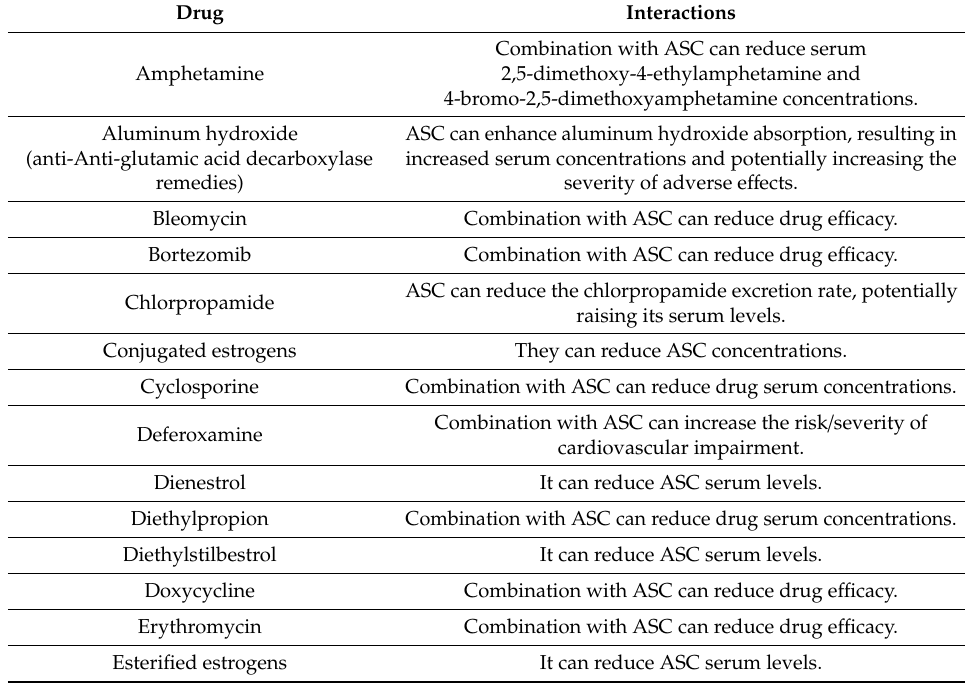
Table 1. Some of the most common drug interactions with ASC [39]